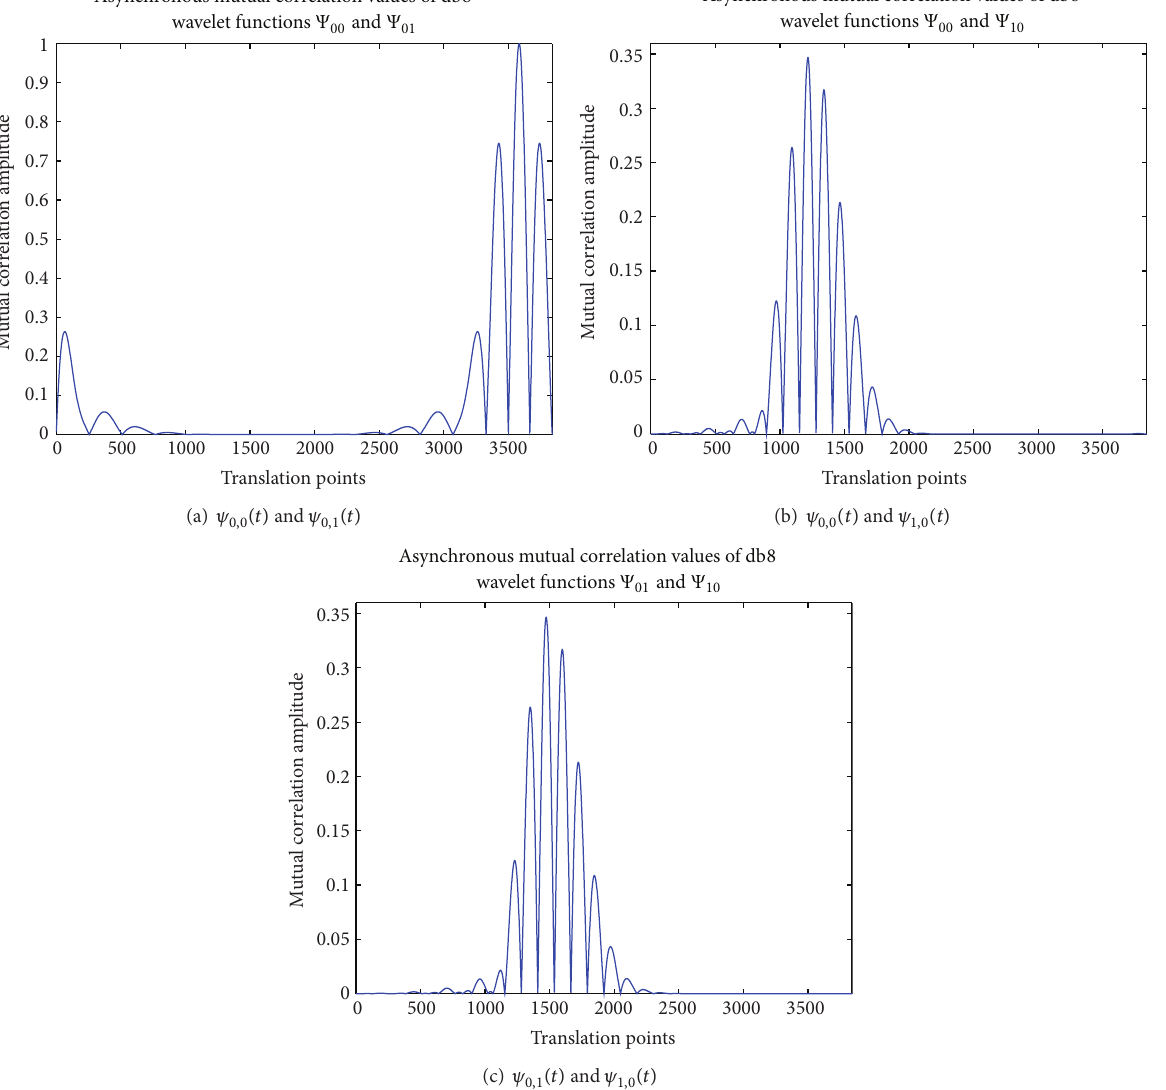
Figure 3: Asynchronous mutual correlation values of three db8 wavelet functions.